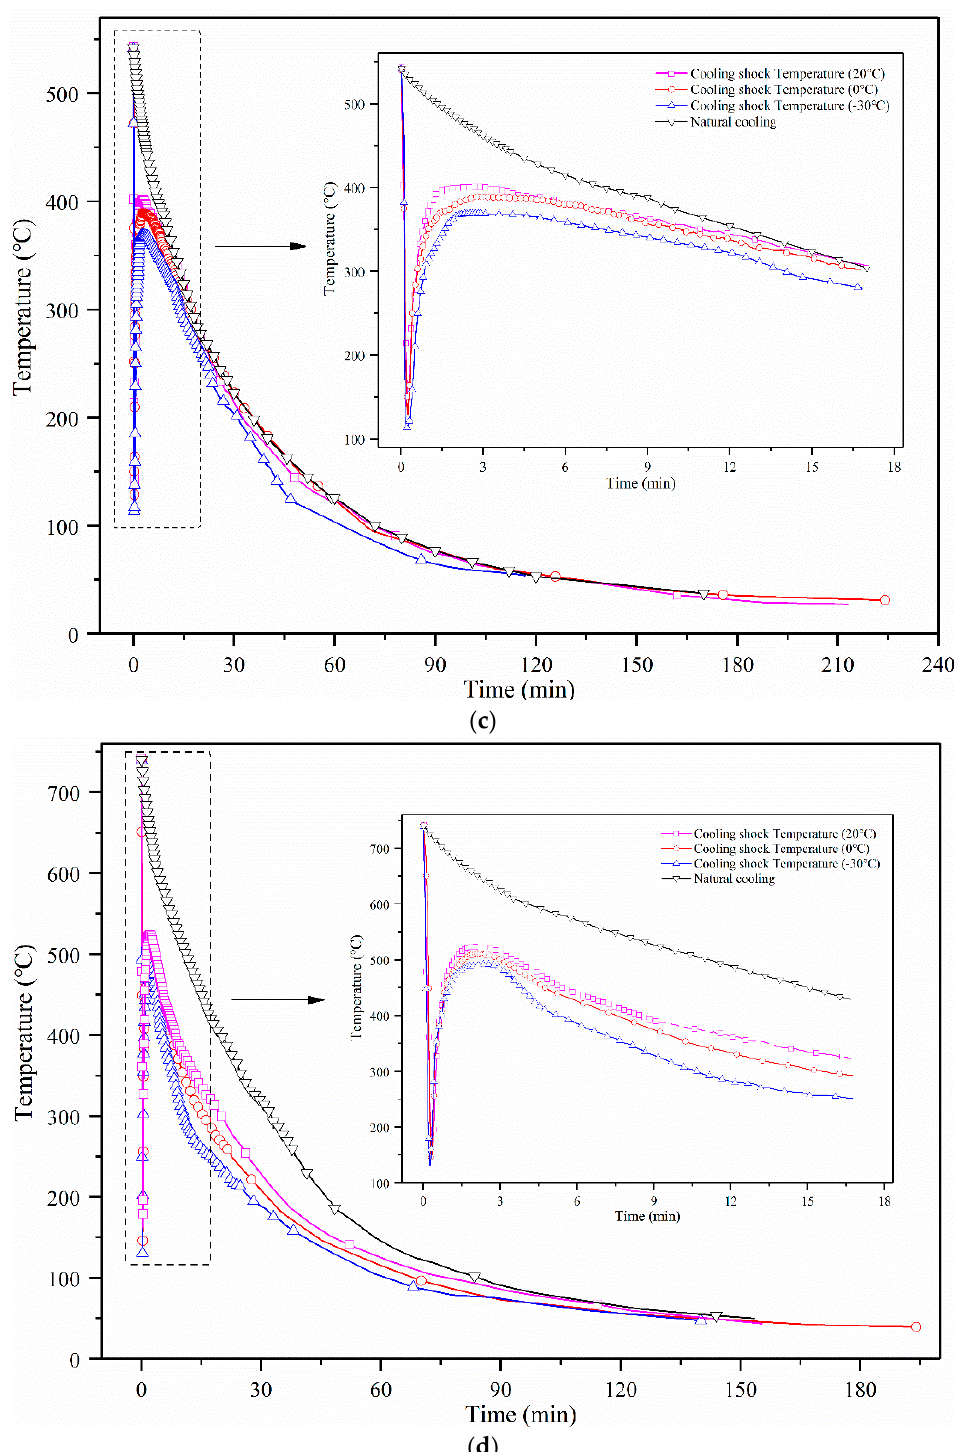
Figure 3. Temperature changes of high temperature granite under cooling shock: ( a ) initial granite temperatures of 150 °C, ( b ) initial granite temperatures of 350 °C, ( c ) initial granite temperatures of 550 °C, and ( d ) initial granite temperatures of 750 °C.